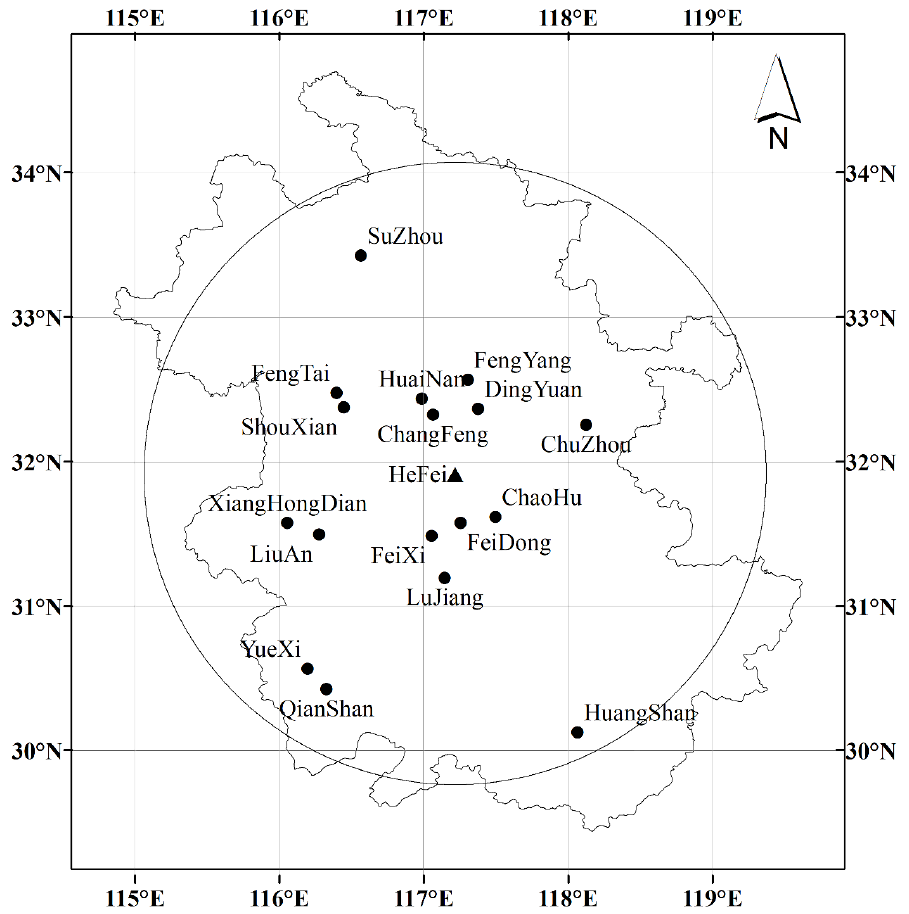
Figure 1. The station distribution map, in which the dots are the disdrometers, the triangle in the center is the radar, and the circle is the 230 km detection range of the